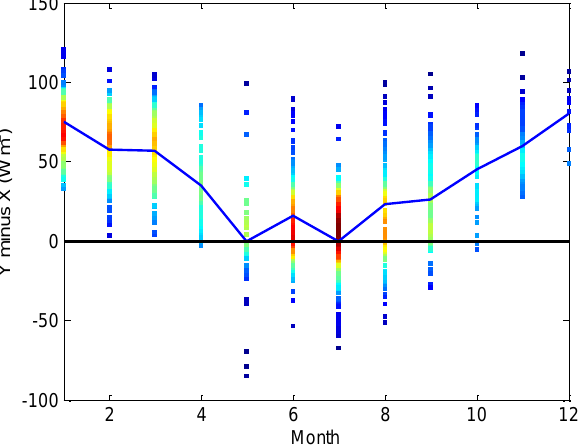
Figure 8. Residuals (McClear GHI minus ground measured GHI) versus the month for Aswan under cloud-free conditions. The blue line presents the monthly mean of the residuals.